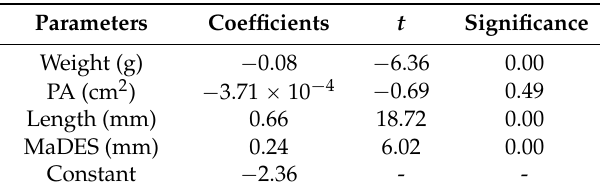
Table 2. Statistical results of the stepwise multiple linear regression (SMLR) model for determining MiDES of the kiwifruits.